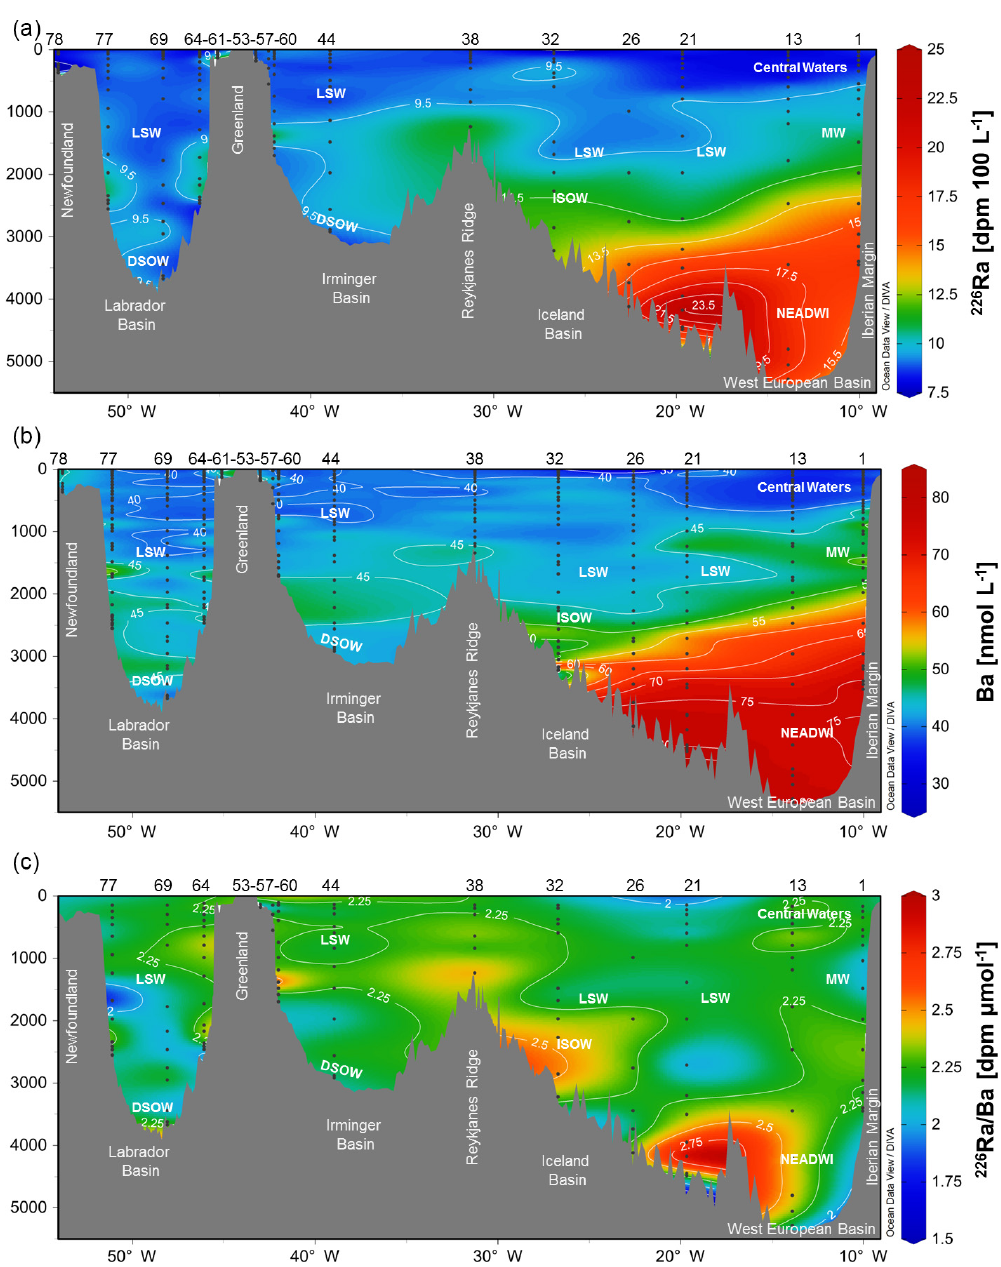
Figure 4. Distribution of (a) dissolved 226 Ra activities (dpm100L − 1 ) , (b) dissolved Ba concentrations (nmolL − 1 ) and 226 Ra / Ba ratio (dpmµmol − 1 ) along the GA01 section. Station numbers are found above the panels. The sampling depths are shown for each vertical profile (black